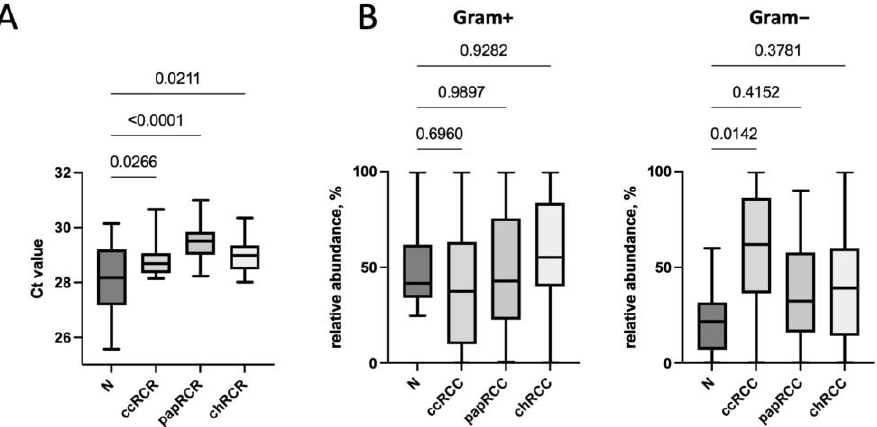
Figure 3. Total bacterial load ( A ), as well as the relative content of Gram-positive and Gram-negative bacteria ( B ), depending on the histological type of the tumor. p -values are indicated above the lines.